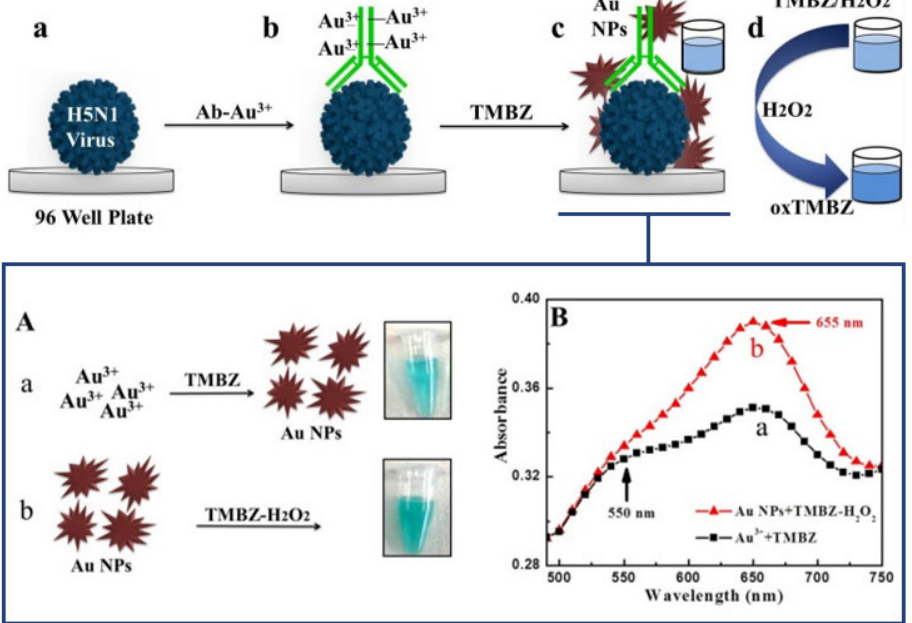
Figure 13. Platform preparation and determination principle for the determination of H5N1. ( a ) Virus deposition; ( b ) Recognition of H5N1 virus by a selective antibody modified with Au ions; ( c ) Au nanostructures formation upon TMBZ addition, resulting in a bluish-green color; ( d ) Color change of the solution as a consequence of TMBZ oxidation upon the presence of H 2 O 2 . Inset: ( A ) Principle for the appearance of the bluish-green color; and ( B ) resulting UV-Vis spectra. Reprinted with permission from [58]. Copyright © 2017 Nanotheranostics.